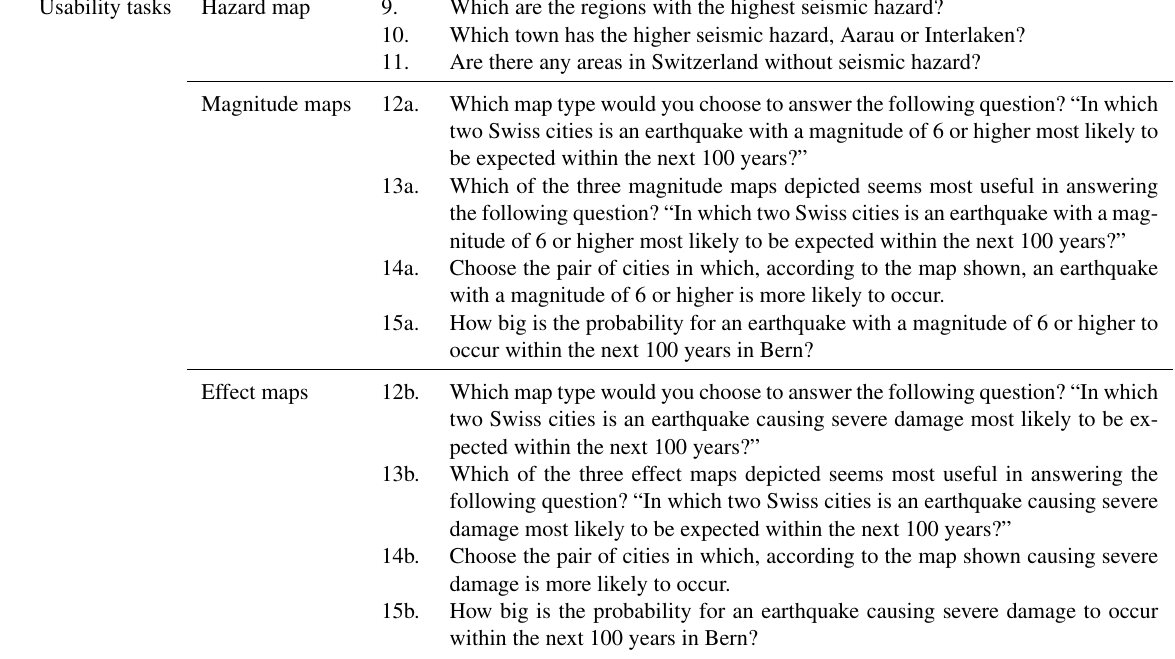
Table 2. Survey section with usability tasks. The public answered the questions online, and the workshop participants noted their answers on a flip chart. The public solved the usability task as part of the online survey, and workshop participants needed to use the SED website to find their answers. Translated from German to English by the